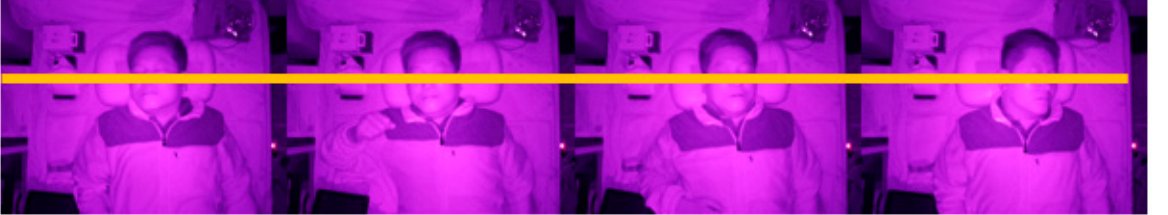
Figure 13. Snapshots of the left-to-right tossing.